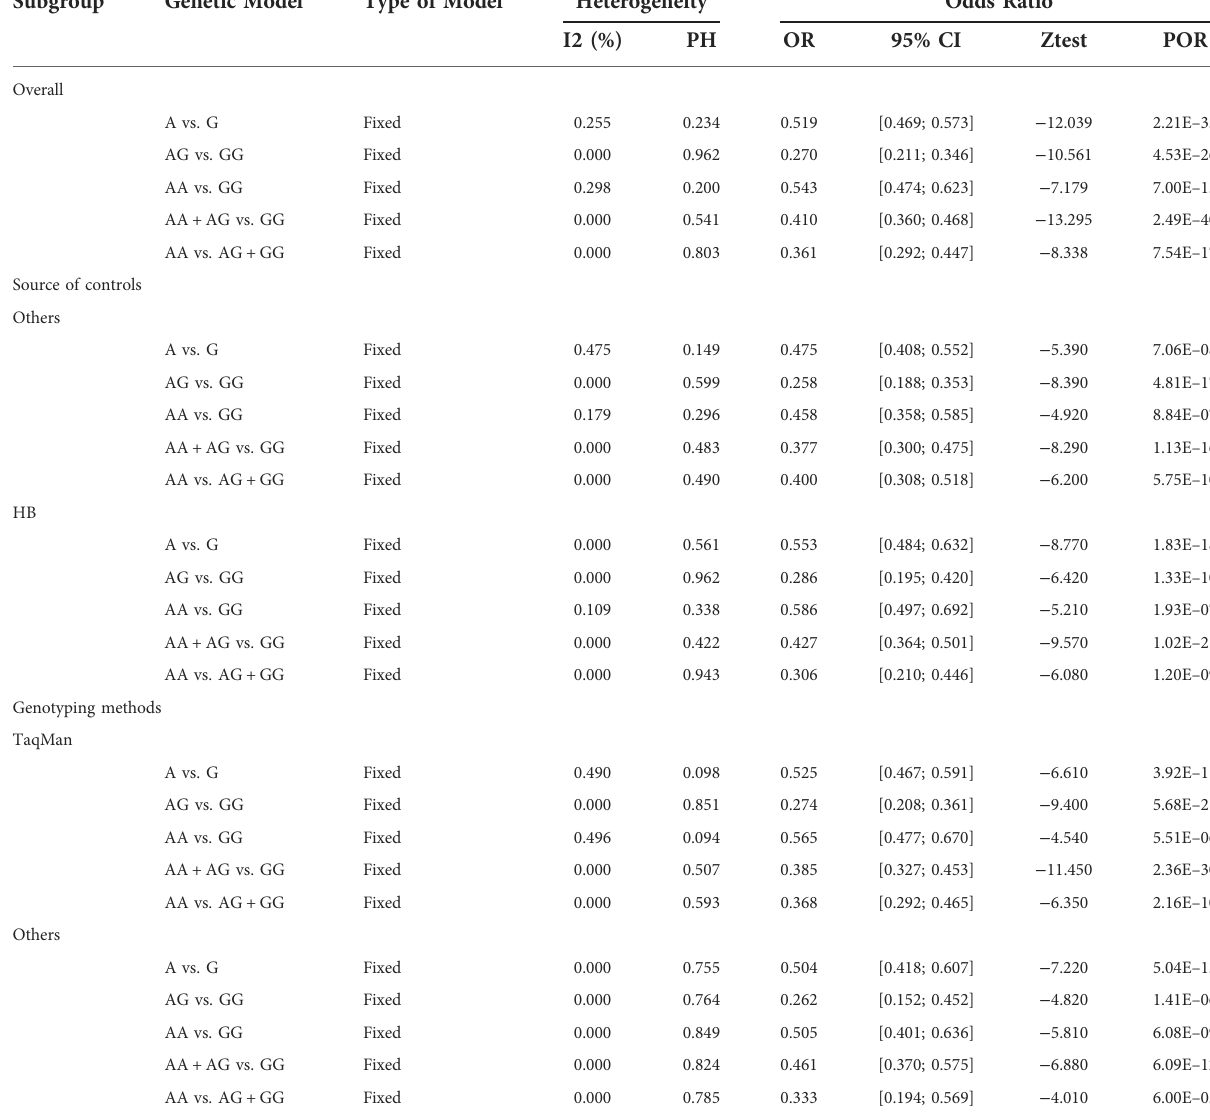
TABLE 4 Analysis results of the association between rs2506030 and HSCR risk.